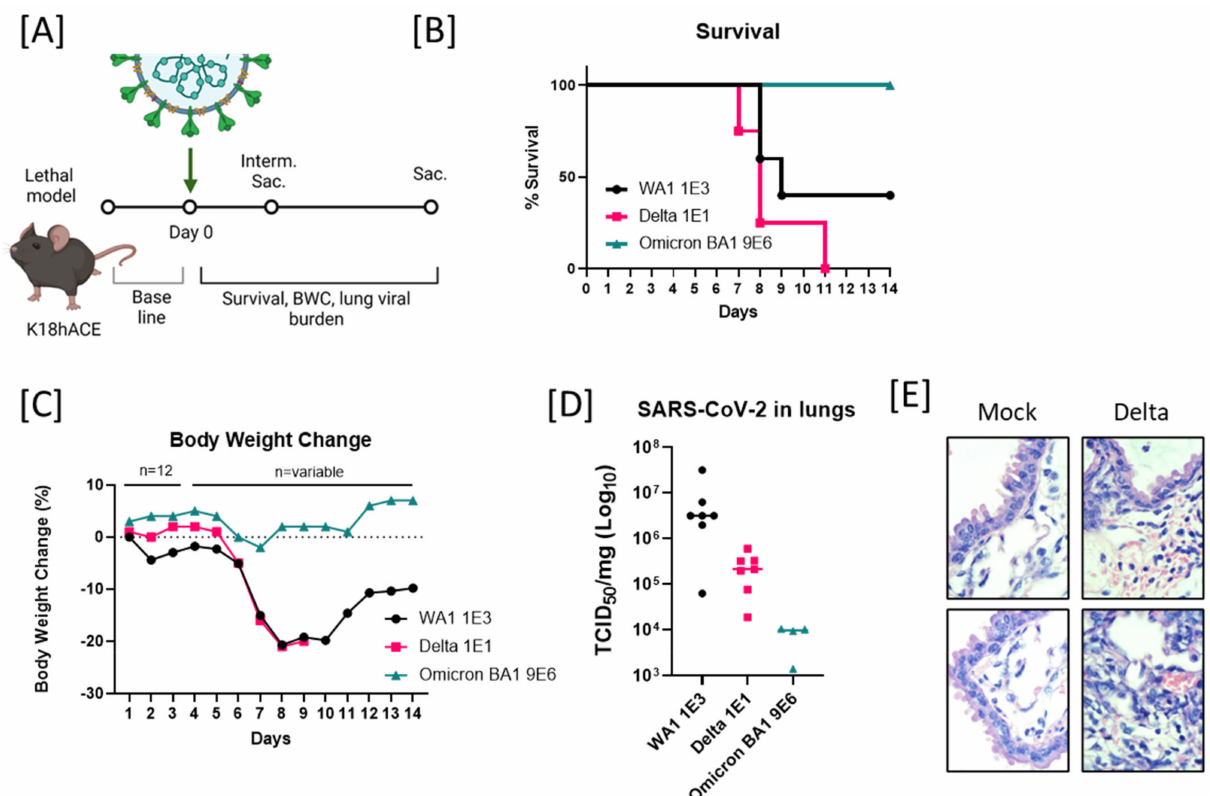
Figure 1. B.1.617.2 (Delta) showed enhanced lethality in infected K18-hACE2 mice. ( A ) Schematic diagram of SARS-CoV-2 infection and experimental design. Interim Sac = scheduled interim sac- rifice/euthanasia. Sac. = final euthanasia. Created with BioRender.com. Animals ( n = 12) were intranasally inoculated with SARS-CoV-2 on day 0. Body weights before challenge were used to establish baseline. Survival and body weight change (BWC) were observed or collected daily. Lungs were collected at the interim and terminal euthanasia. ( B ) Survival in mice model after 14 days postchallenge with 1 × 10 3 TCID 50 of WA1, 1 × 10 1 TCID 50 of B.1.617.2 (Delta), and 9 × 10 6 TCID 50 of B.1.1.529/Omicron BA1. ( C ) Body weight changes comparison between 1 × 10 3 TCID 50 of